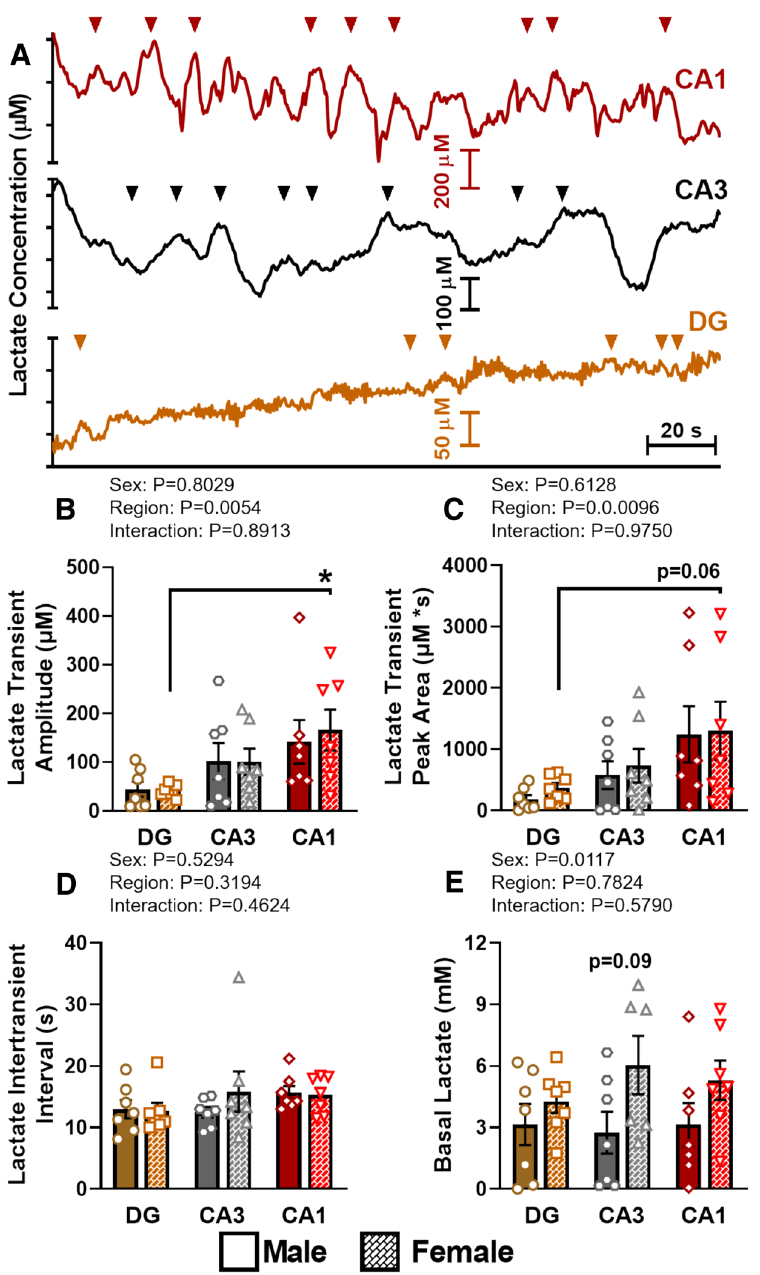
Figure 1. Transient and basal hippocampal lactate. Representative transient lactate release ( A ) is shown in the DG (brown), CA3 (black), and CA1 (red) of female C57BL/6 mice. Note the different scales of the ordinate y-axis in each subregion and color-coordinated triangles identify transient release events. The average lactate transient amplitude ( B ), peak area ( C ) and intertransient interval ( D ) were averaged for each hippocampal region and sex. *p < 0.05; n = 6–7. A measurement without detectable lactate transients was used to calculate basal lactate levels ( E